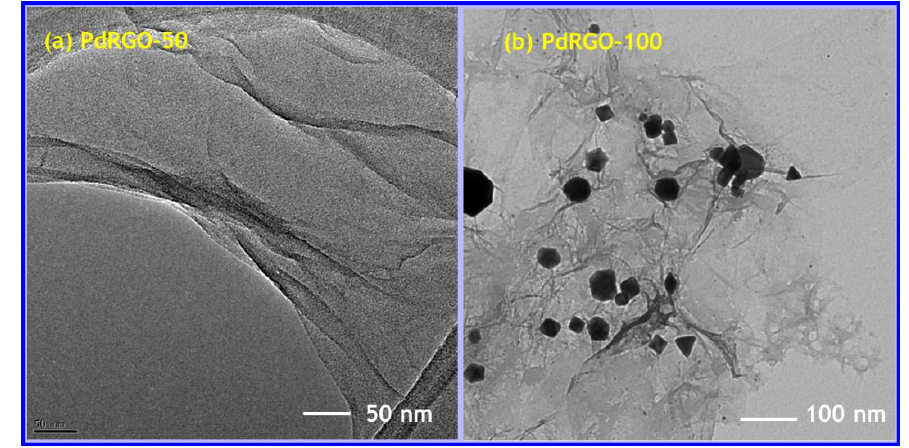
Figure 4. TEM images of green synthesized nanostructures: ( a ) RGO and ( b ) RGO-PN-100.